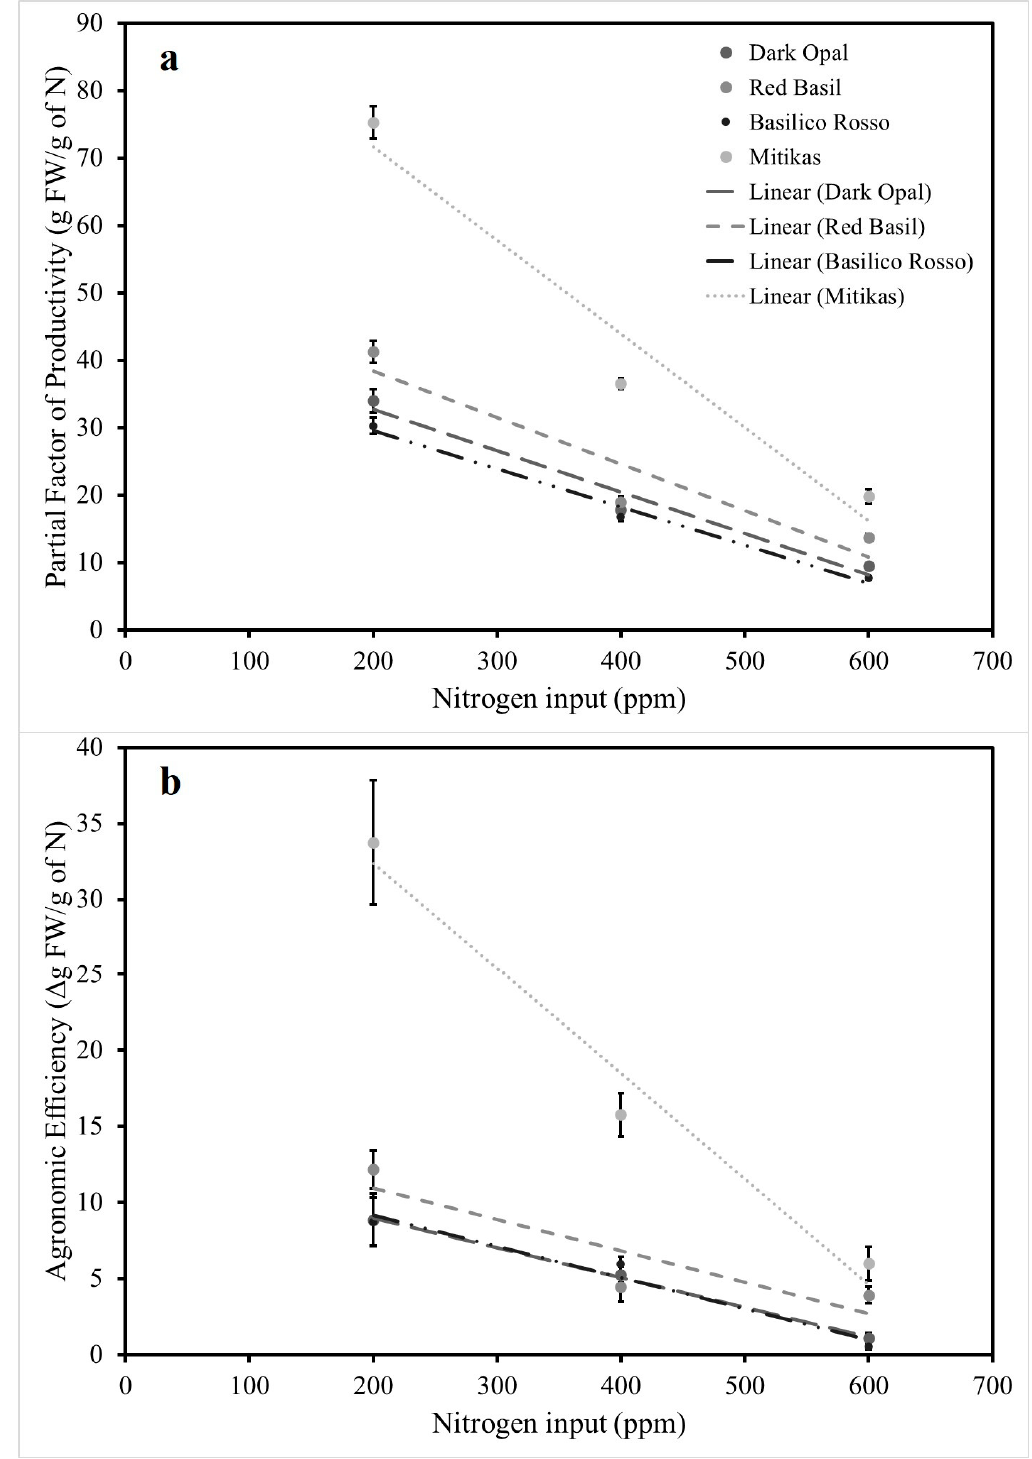
Figure 2. Effect of nitrogen input on ( a ) partial factor of productivity and ( b ) agronomic efficiency of applied nitrogen fertilizer in Dark Opal, Red Basil, Basilico Rosso, and Mitikas Basil.